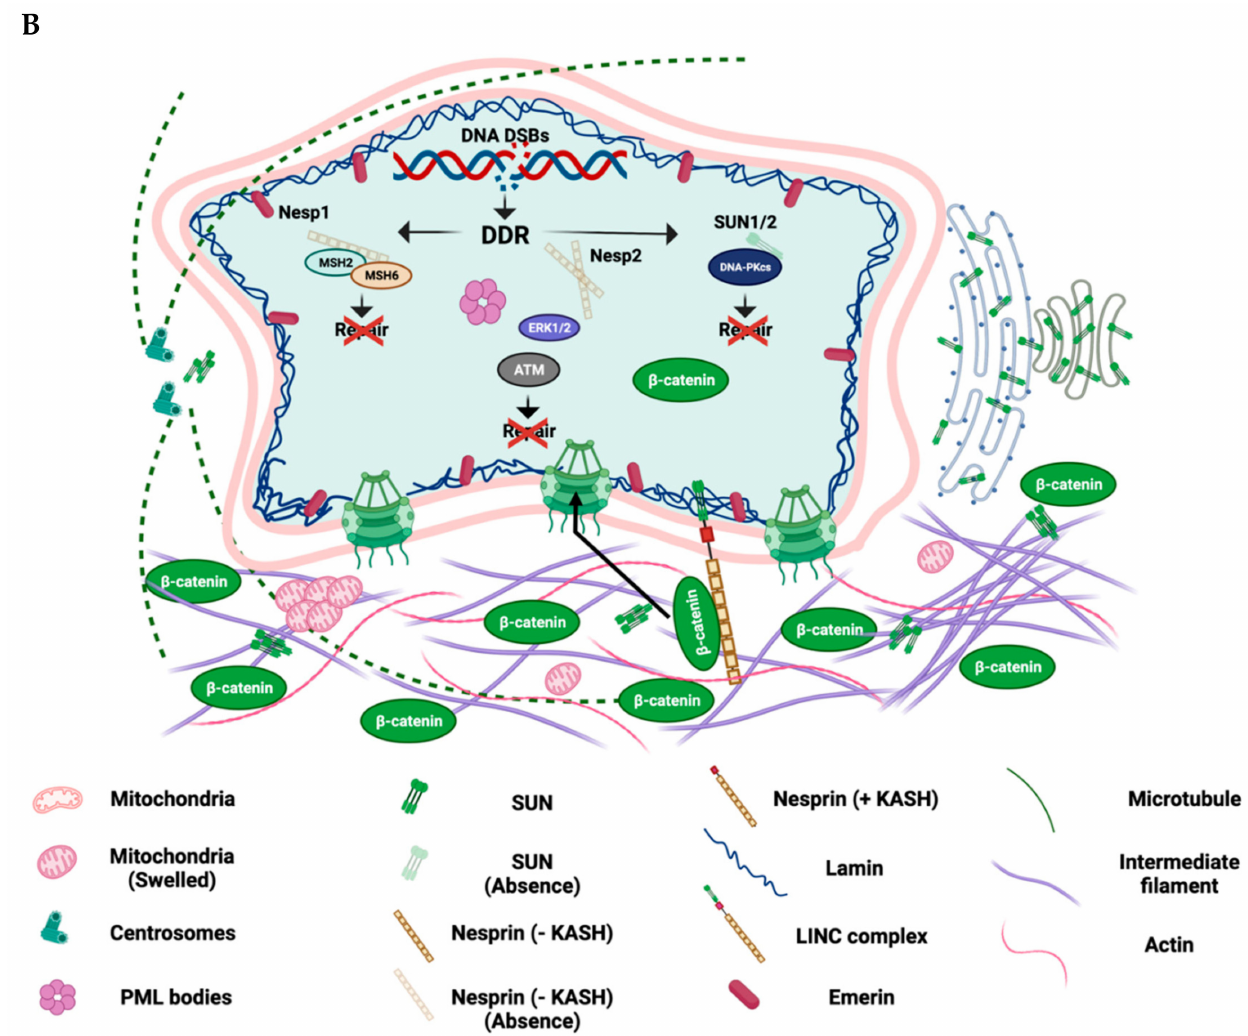
Figure 2. Diagram representing the role of LINC proteins in ( A ) non-senescent and ( B ) senescent cells. ( A ) In non-senescent cells, the mitochondria and cytoskeleton are intact and distributed normally. The nucleus shows a normal shape and size with Lamins lining the inner nuclear membrane and the SUN protein connecting to Nesprins via KASH domains in the PNS. Importantly, DNA damage is repaired through several mechanisms. Three mechanisms that involve LINC complex proteins are shown. ( B ) In senescent cells, mis-localization and aggregation of swelled mitochondria near the nuclear envelope (NE) and an irregular nuclear shape are associated with changes in Nesprins. Loss of Nesprins and SUN proteins lead to an accumulation of DNA damage. Loss of Nesprin-2 leads to a loss of β -catenin from the nucleus. In addition, SUN proteins form cytoplasmic aggregates, can accumulate in the Golgi and can promote ER distension. This figure was created with BioRender.com (accessed on 20 May